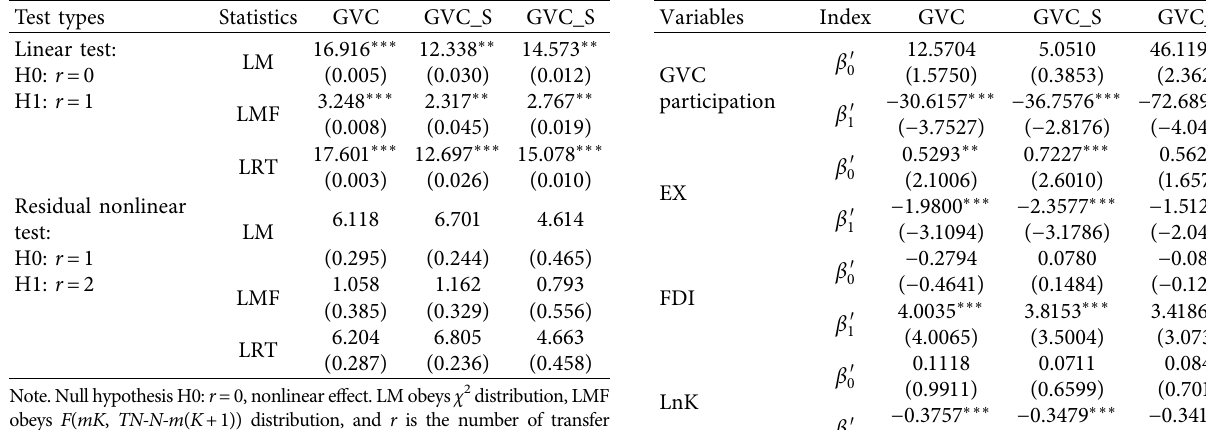
Table 2: Linear test and residual nonlinear test results.